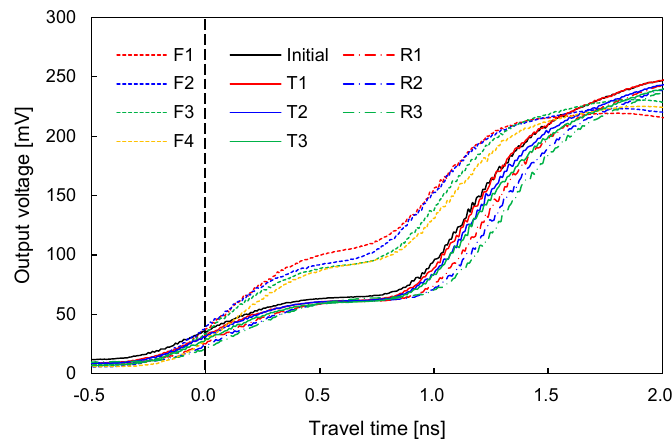
Figure 6. Typical signals of TDR during freeze-thaw cycles of sand–silt mixture at SF = 70% and N = 1000. Fn, Tn, and Rn denote the freezing (F), thawing (T), and repetitive loading (R) at nth cycle, respectively.